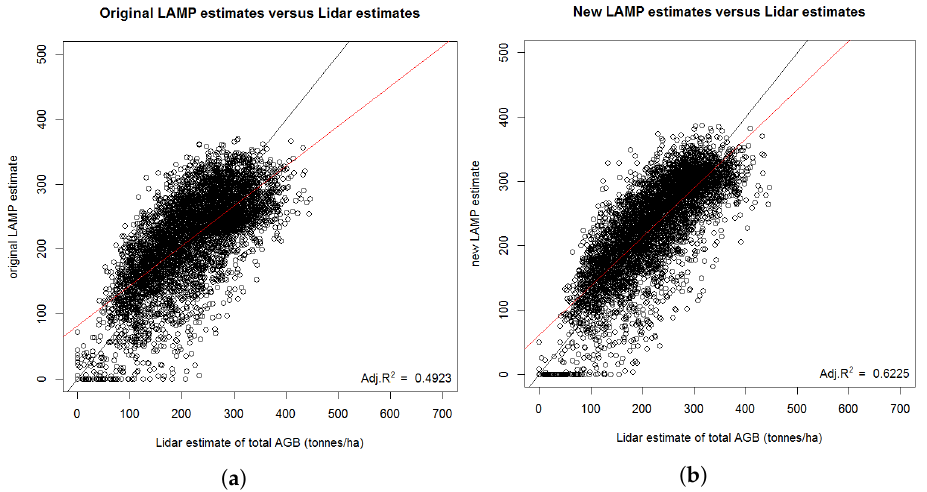
Figure A2. AGB predictions with LAMP3 at 1-hectare scale compared to Lidar estimates. ( a ) OLSLAMP; ( b ) after LAMP3. Regression trend line of the linear model in red, optimal trend line in black.